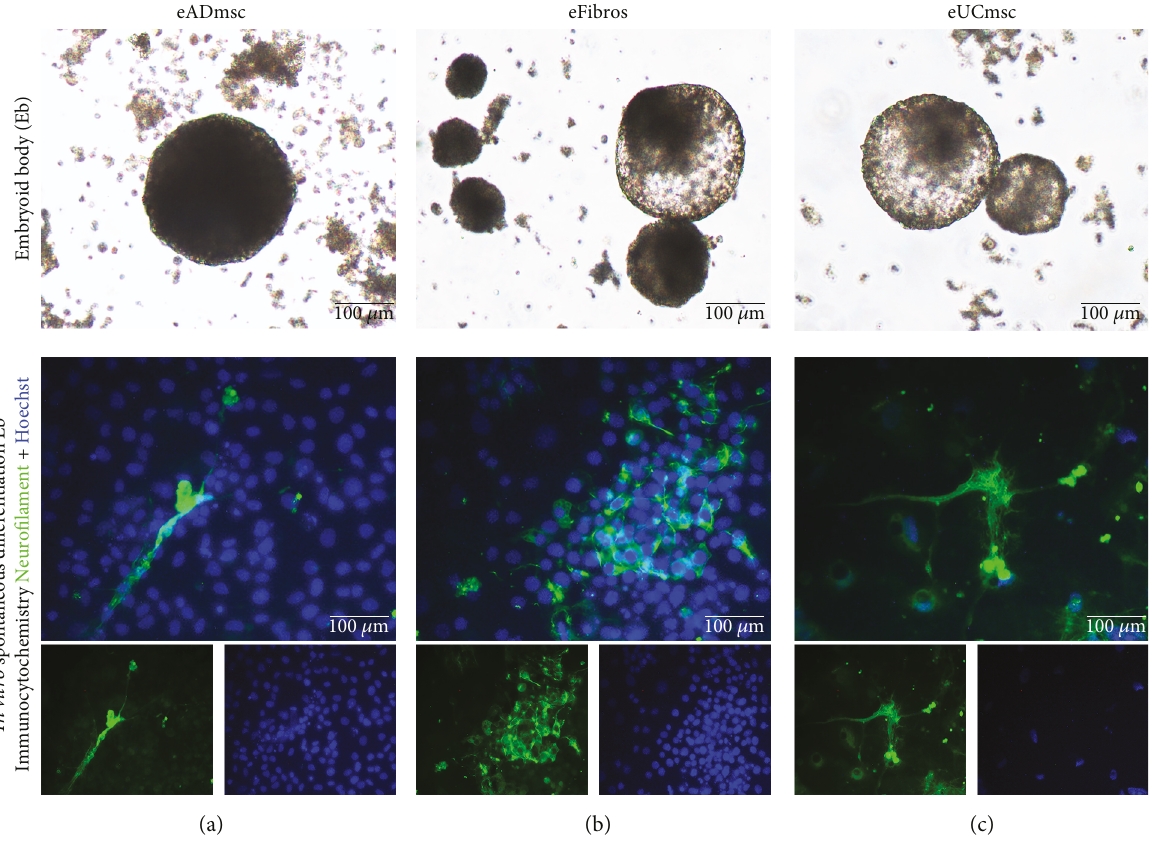
Figure 3: Four-day-old EBs produced from equine iPSCs derived from (a) adipose tissue mesenchymal cells, (b) fi broblasts, and (c) umbilical cord tissue mesenchymal cells. After the spontaneous di ff erentiation of embryoid bodies into multiple lineages, the cells presented a more elongated morphology and were immunocytochemically positive for neuro fi lament. Merged images of neuro fi lament/FITC and Hoechst staining: (a) eiPSCs-eADmsc-derived cells, (b) eiPSCs-eFibros-derived cells, and (c) eiPSCs-UCmsc- derived cells,